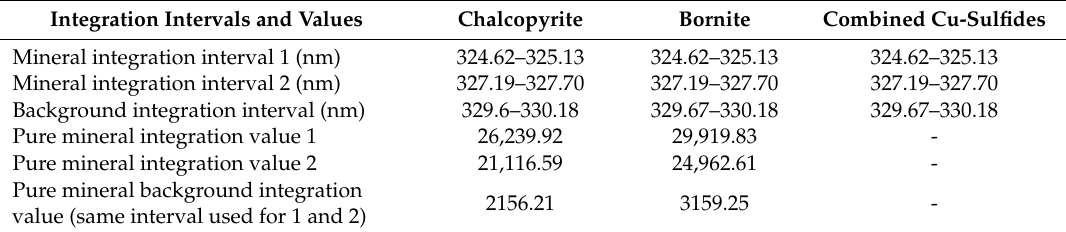
Table 2. Integration intervals used to calculate the proportion of copper minerals present in each spot interrogated by laser-induced breakdown spectroscopy (LIBS)